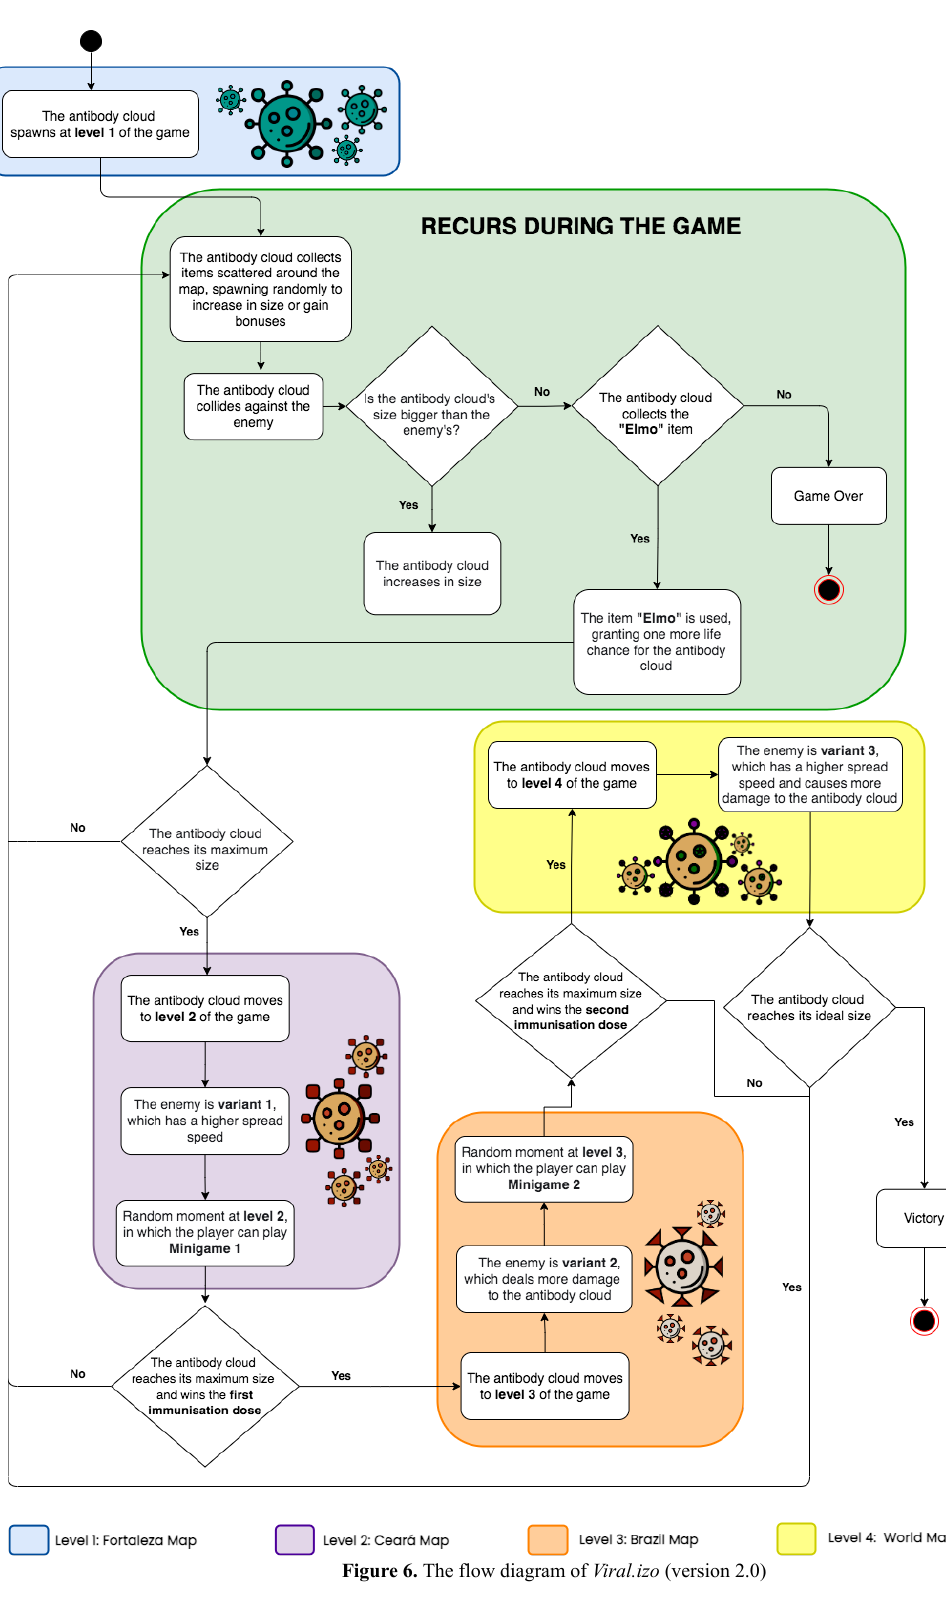
Figure 6. The flow diagram of Viral.izo (version